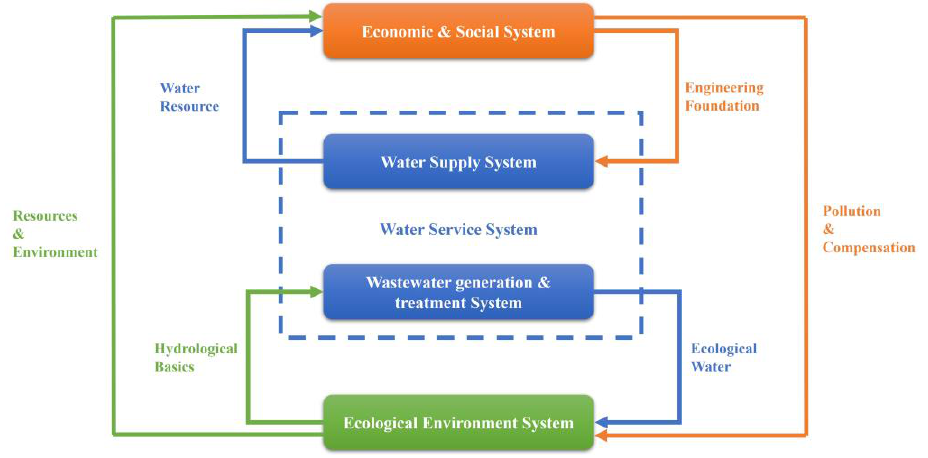
Figure 2. Structure of the regional water resource